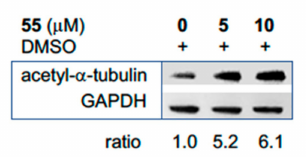
Figure 2. Determination of α -tubulin acetylation in NCI-H460 cells by western blot following 18 h treatment with 55 . GAPDH used as loading